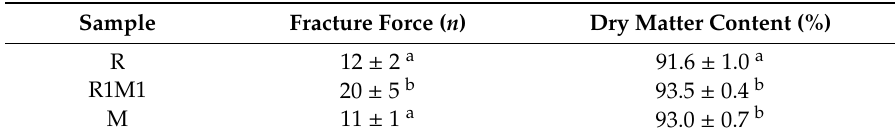
Table 4. Fracture force and dry matter content of printed single-layer samples after baking and storage.